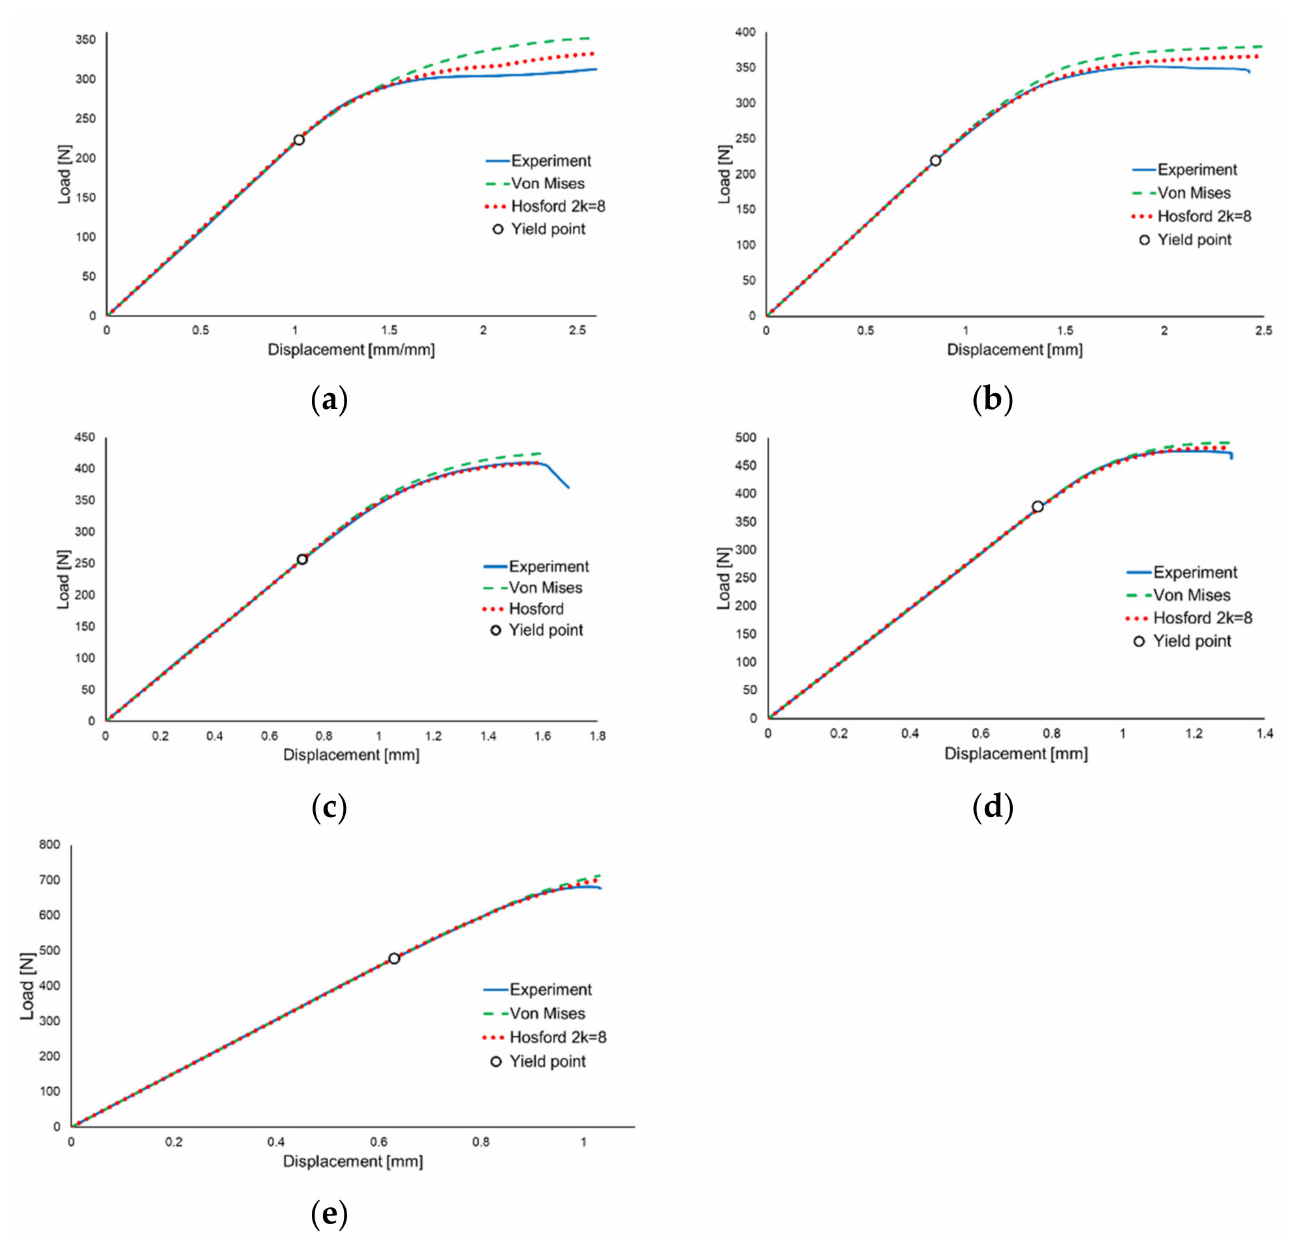
Figure 9. Numerical analyses results for the von Mises and Hosford materials for 0 ◦ ( a ), 15 ◦ ( b ), 30 ◦ ( c ), 45 ◦ ( d ) and 90 ◦